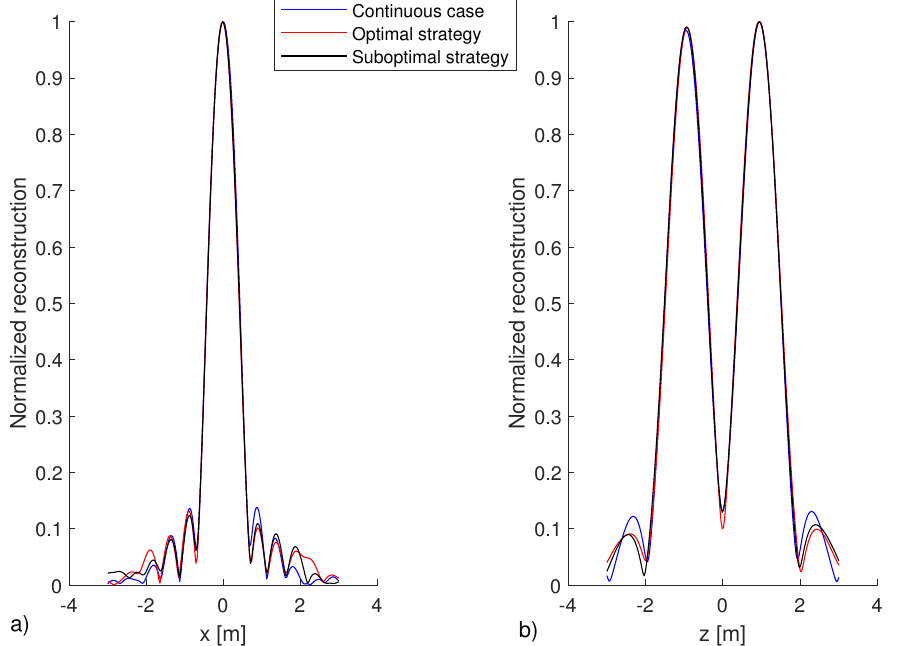
Figure 9. Cut views along x and z axis passing by ( 0,1 ) , i.e., where the maximum of the normalized reconstructions reported in Figure 8 are located. SNR = 20